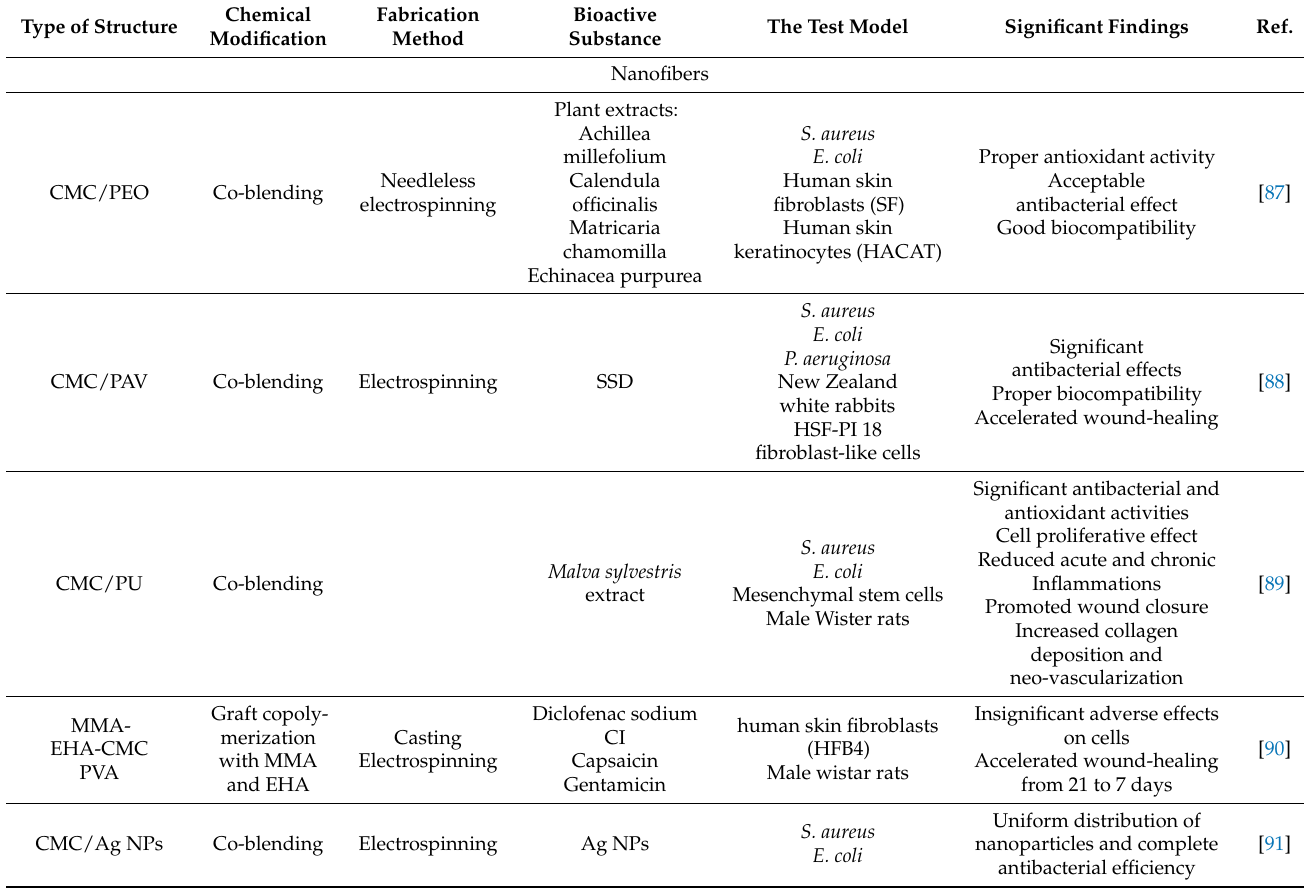
Table 2. CA-based biomaterials fabricated and applied for wound-healing applications. Type of